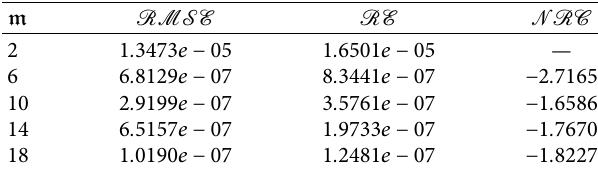
Table 4: RMSE , RE , and NRC for diferent m for Example 4.